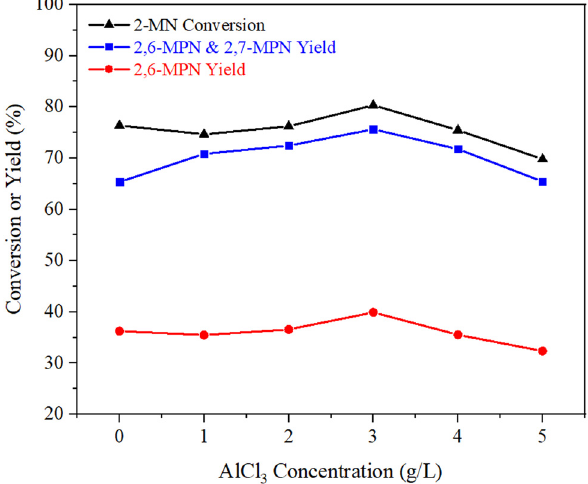
Figure 5: Possible binding form of AlCl 3 and Si – OH after loading on molecular sieve.